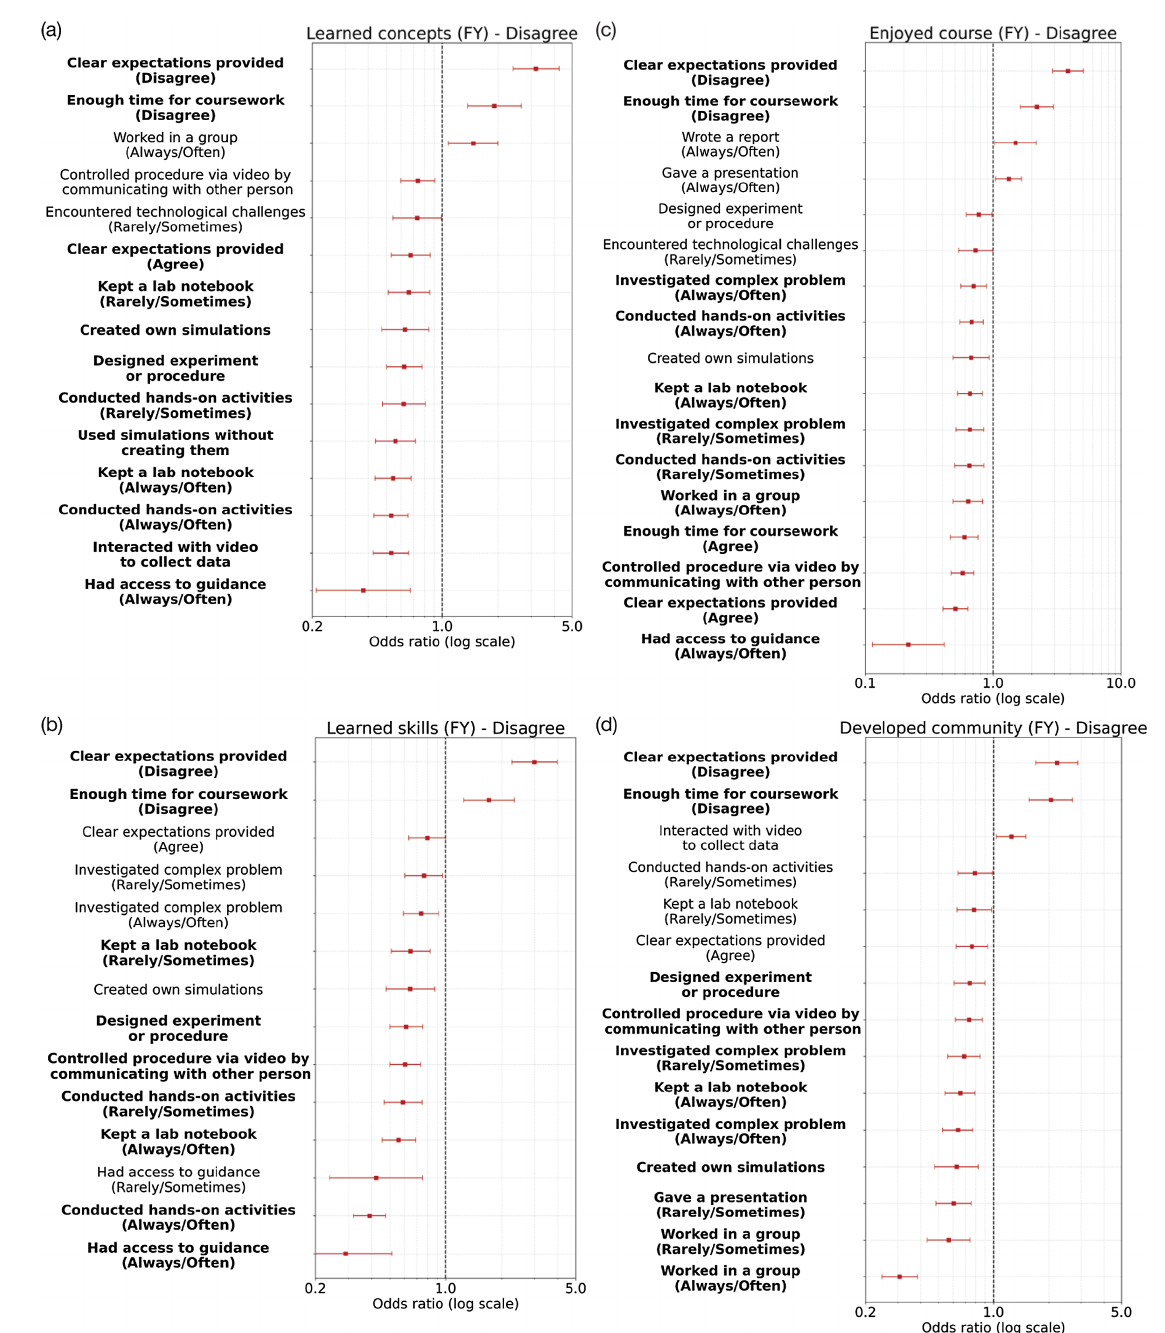
FIG. 11. Logistic regression odds ratios for students who disagreed or strongly disagreed that they (a) learned concepts, (b) learned lab skills, (c) enjoyed the course, and (d) developed a sense of community. Only variables with uncorrected p values less than 0.5 are shown. Bold variables are those that are statistically significant after the Holm-Bonferroni correction. Error bars show 95% confidence intervals. Note that the odds ratios are on a log scale to make a decrease in the odds be of an approximately equal size to an